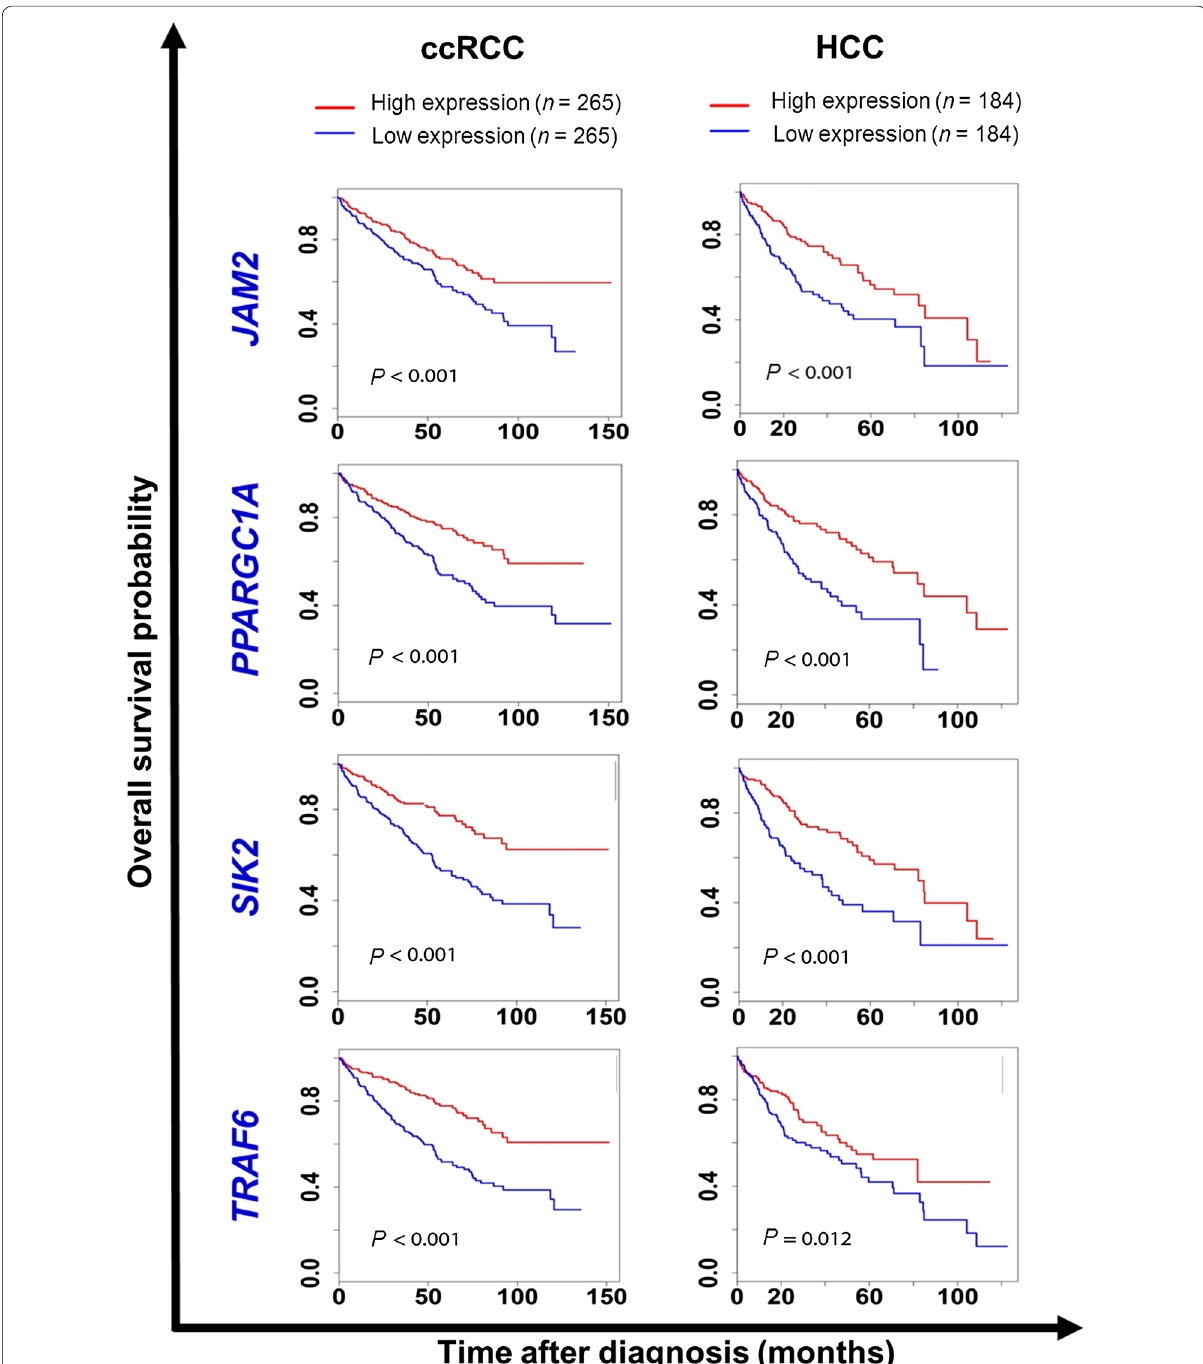
Fig. 1 Survival curves of two cohorts of cancer patients separated by the mRNA levels of four genes. The data were retrieved from The Cancer Genome Atlas database. The survival curves were plotted using the Kaplan–Meier method and compared using the log‑rank test. The median values were used as cutoff values to separate patients into high‑ or low‑expression groups. ccRCC clear cell renal cell carcinoma, HCC